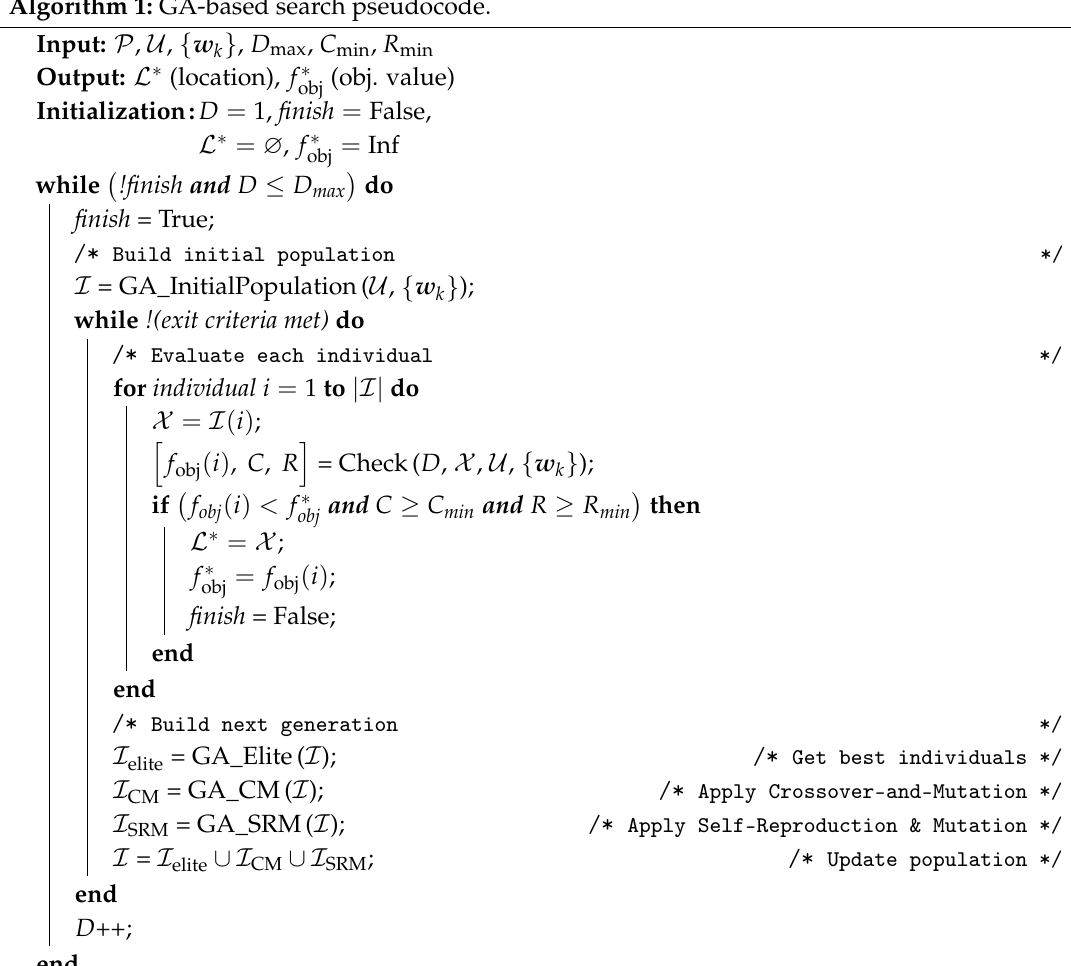
Algorithm 1: GA-based search